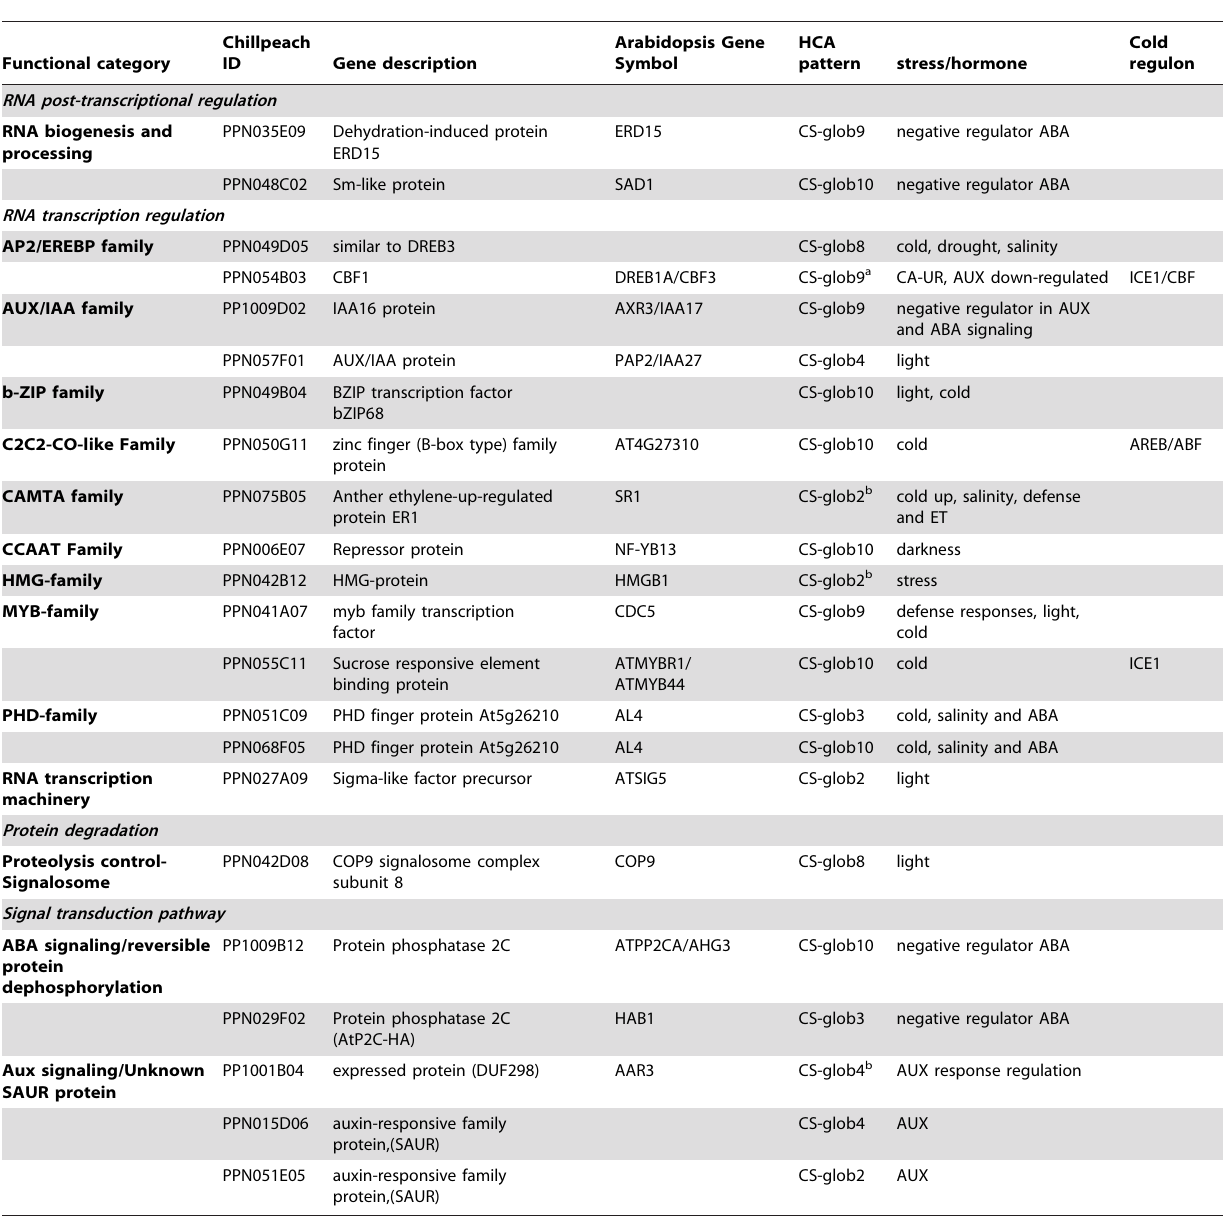
Table 2. Expression Regulators and Signaling Elements with High Expression in Low Sensitive Fruits at One Week of Cold Storage with stress and hormone related